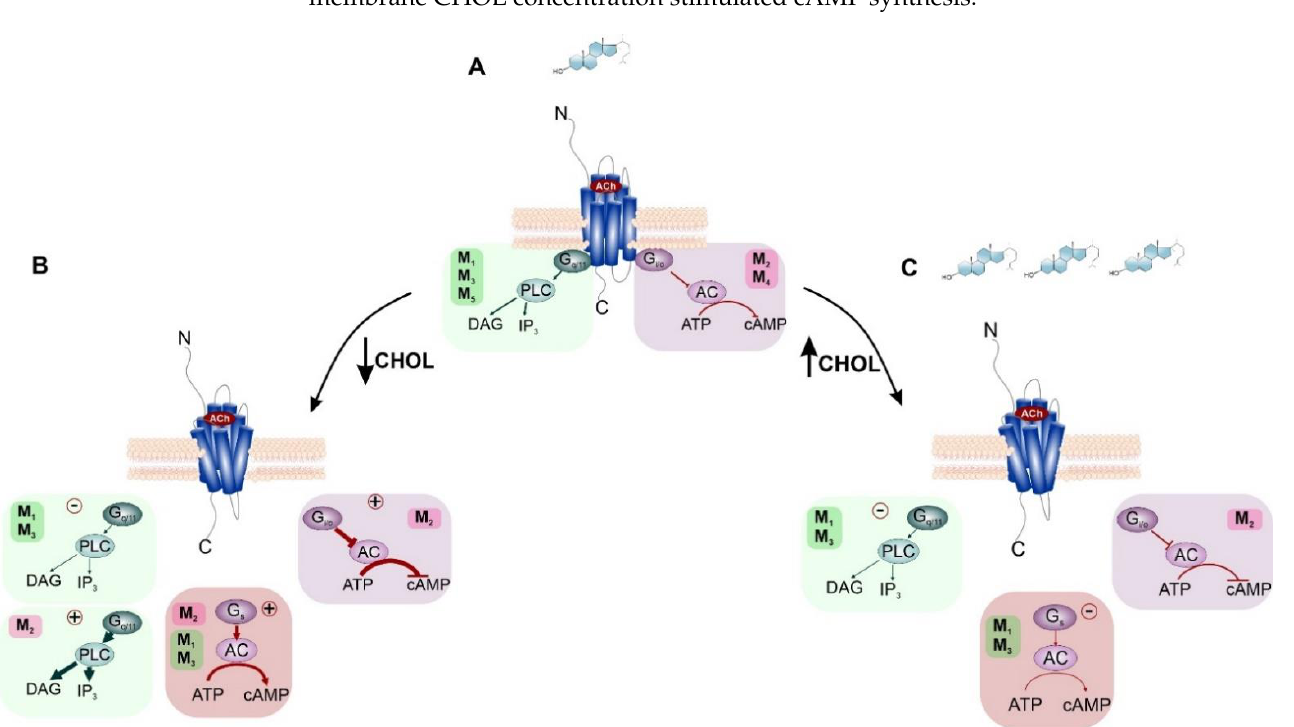
Figure 5. Influence of membrane CHOL content on preferential and non-preferential signaling of mAChRs. ( A ) standard mAChRs signaling in the cell membrane with a natural level of CHOL (light blue steroid molecule). Preferential coupling of M 1 , M 3 , M 5 receptors to G q/11 protein (green box) and M 2 , M 4 receptors coupling to G i/o protein (purple box). ( B ) depletion of membrane CHOL diminishes preferential G q/11 signaling and enhances preferential G i/o and non-preferential G s (red box) and G q/11 signaling. ( C ) increase in membrane CHOL level attenuates signaling via preferential G-proteins.